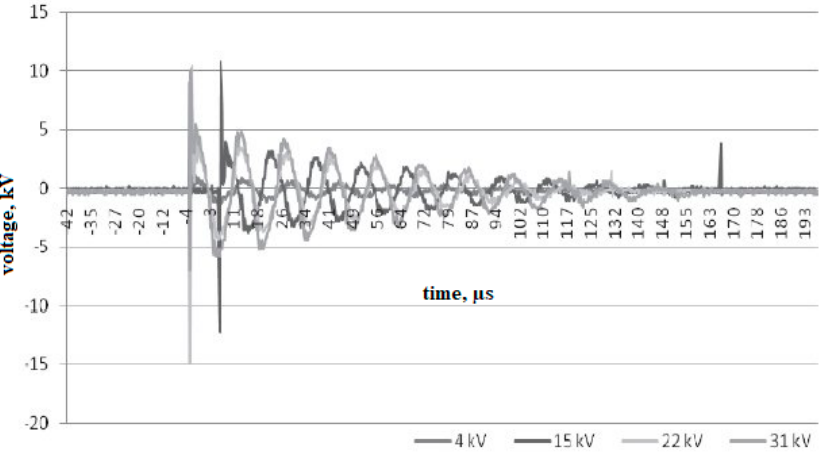
Figure 6. Voltage pulse as a function of time changes depending on the voltage [32].